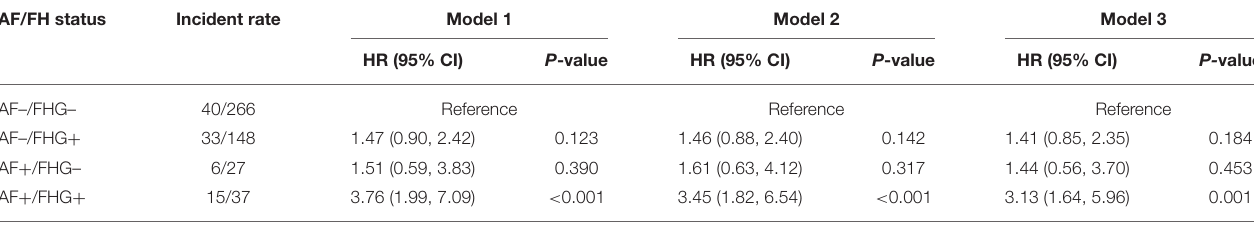
AF, atrial fibrillation; FHG, fasting hyperglycemia. Model 1, adjusted for age, gender; Model 2, further adjusted for smoking, hypertension, previous myocardial infraction, previous stroke; Model 3, further adjusted for previous DM, ejection